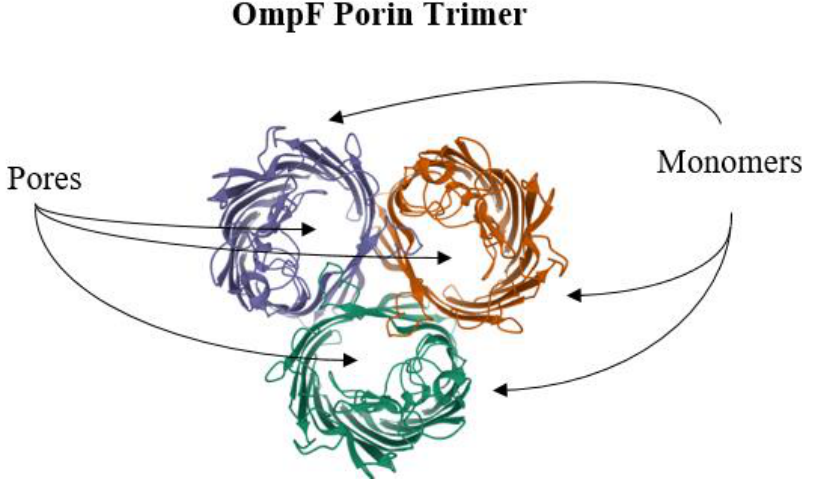
Figure 8. Outer membrane protein, OmpF, is a porin from Escherichia coli . The OmpF porin is a trimeric apparatus consisting of three monomers. The OmpF porin structure was generated with the NGL Viewer [106] from the Protein Database, PDB [107], entry 2OMF from Cowan et al. [174].